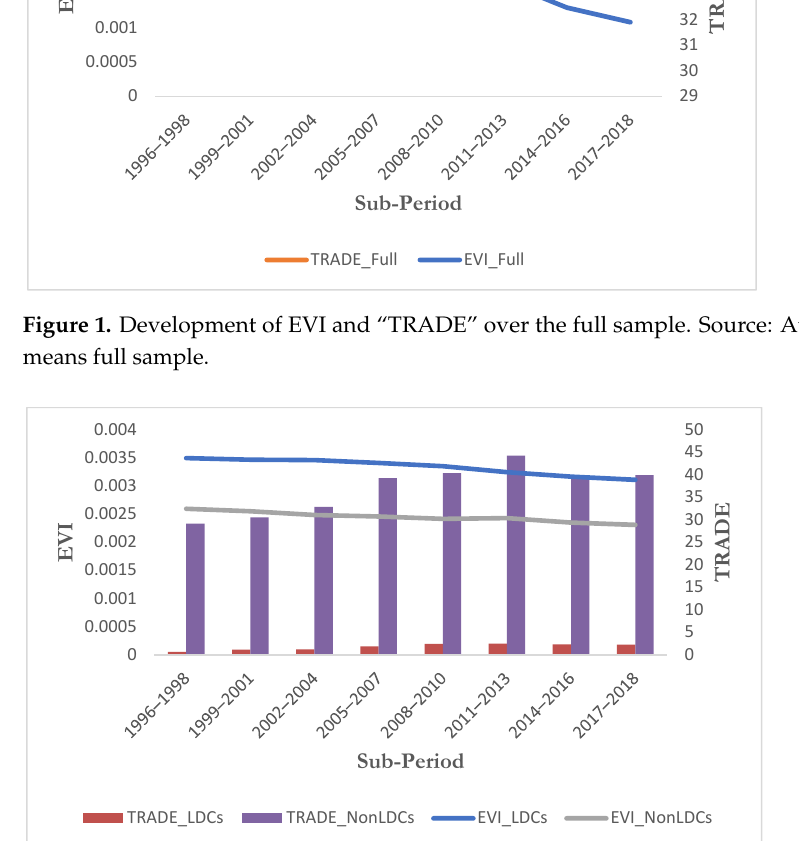
Figure 2. Development of EVI and “TRADE” over LDCs and NonLDCs. Source: Author.